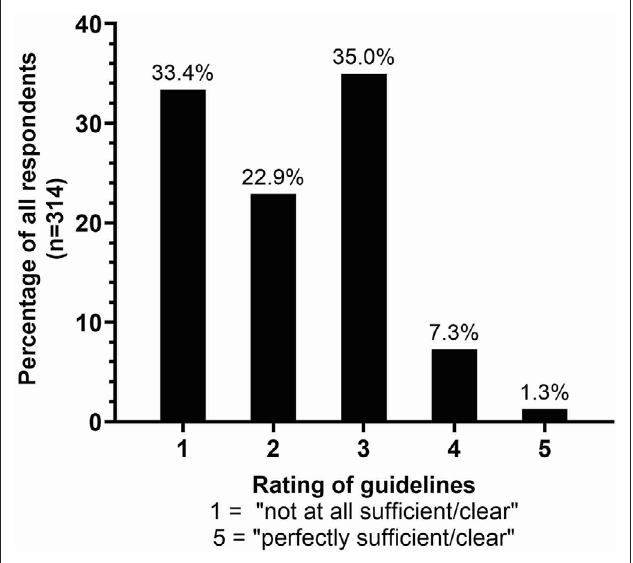
Figure 2 Reported quality rating of current prescription guidelines for NF, across all responders of the questionnaire. NF =